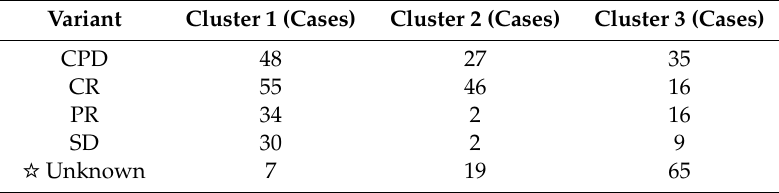
Table 1. Response to chemotherapy. CPD represents clinical progressive disease, CR represents complete response, PR represents partial response, and SD represents stable disease.